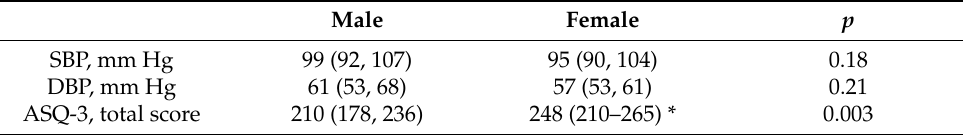
Table 1. Systolic blood pressure (SBP), diastolic blood pressure (DBP) and total score on the Ages & Stages Questionnaire (ASQ-3) are contrasted for 2-year-old male and female children. Data are presented as median (interquartile range).